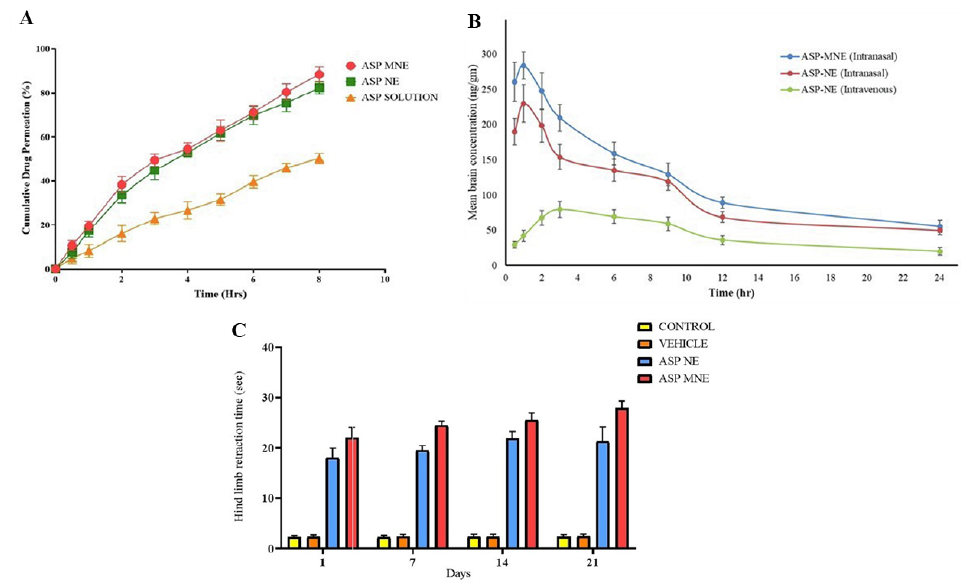
Figure 4. ( A ) Ex vivo drug permeation results of asenapine non-mucoadhesive nanoemulsion